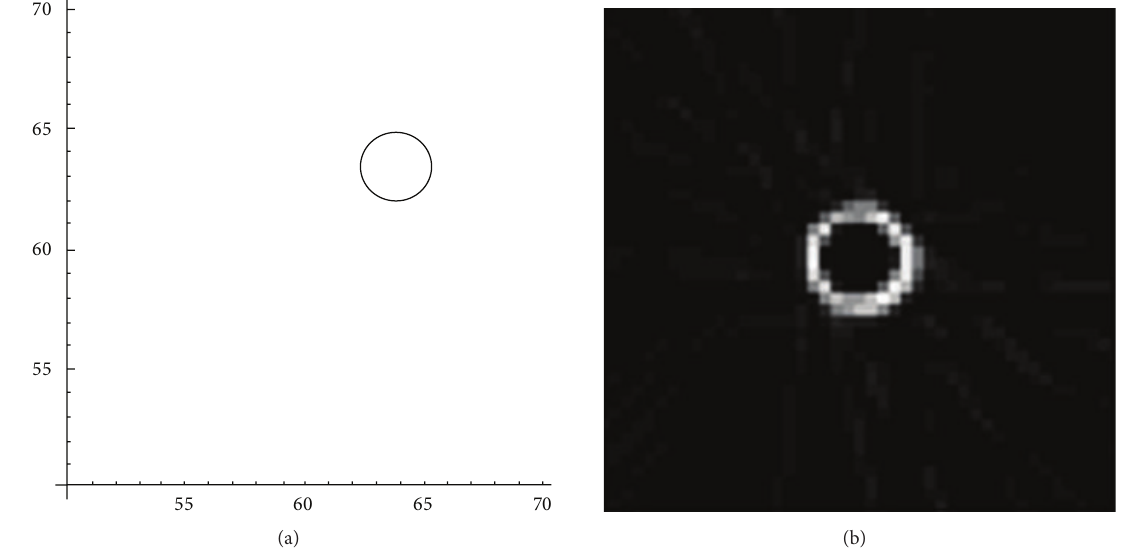
Figure 8: Analysis of artifacts caused by the offset of an isocenter: (a) the trajectory of 𝑀(𝛽) ; (b) the reconstruction image.